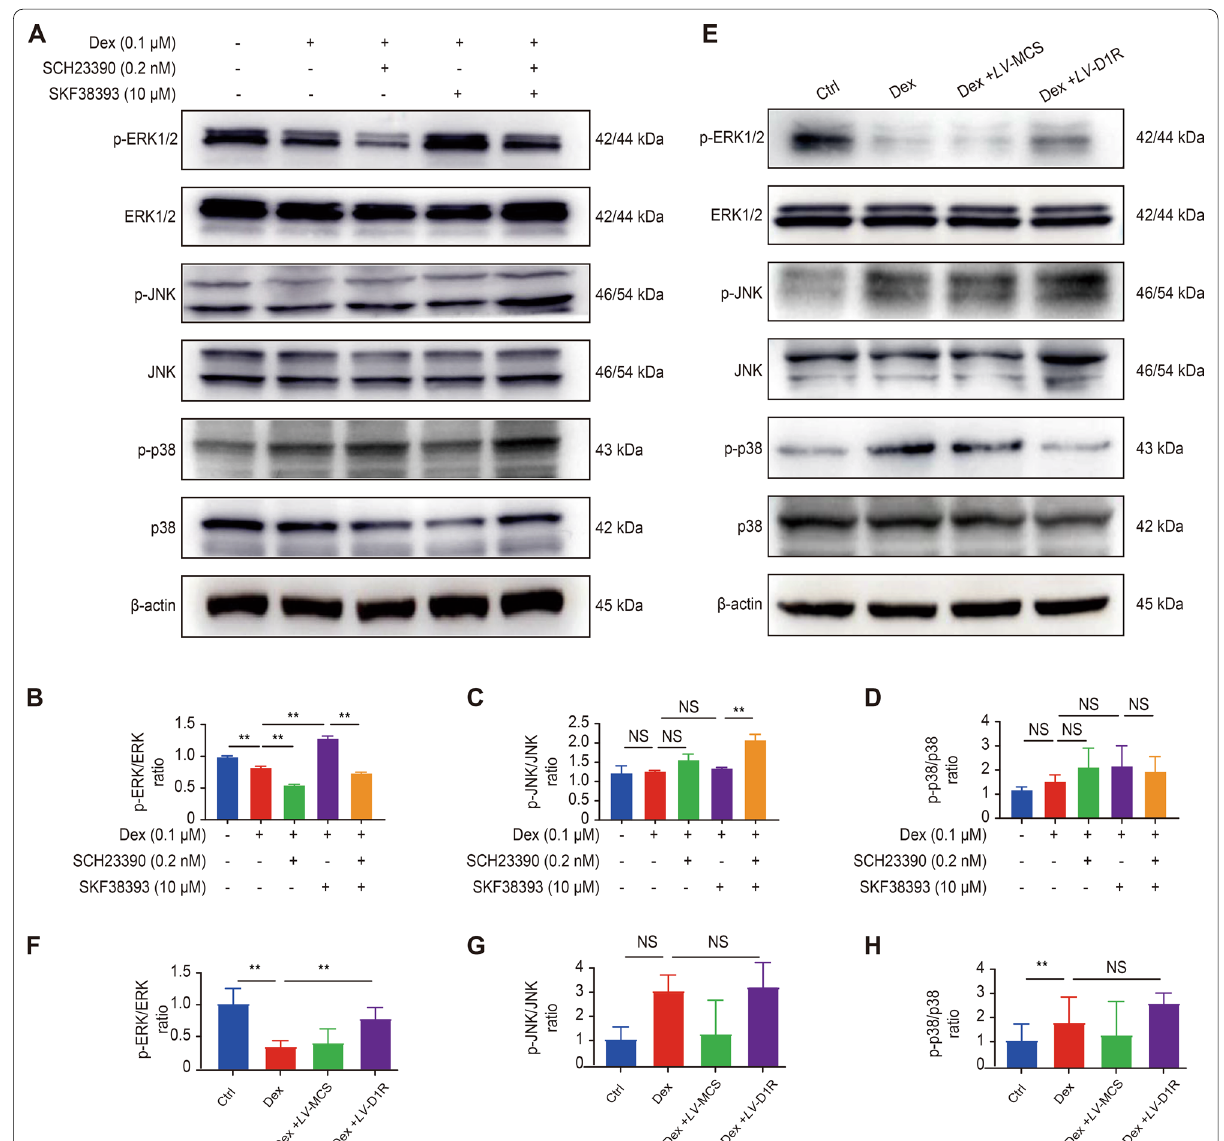
Fig. 4 The ERK1/2 pathway was involved in the protective effect of D1R against Dex-induced osteoblasts in vitro. A Representative images of western blots probed with antibodies against the MAPK signaling pathway proteins p-ERK1/2, ERK1/2, p-JNK, JNK, p-p38, and p38 after 30 min’ Dex treatment. B – D The ratios of p-ERK1/2/ERK1/2, p-JNK/JNK, and p-p38/p38. n 3 per group. NS: Not statistically significant, * p < 0.05, ** p < 0.01, = vs. the control group. E Representative images of western blots probed with antibodies against the MAPK signaling pathway proteins p-ERK1/2, ERK1/2, p-JNK, JNK, p-p38, and p38 in the overexpression experiment. F – H The ratios of p-ERK1/2/ERK1/2, p-JNK/JNK, and p-p38/p38. n 3 per = group. NS: Not statistically significant, * p < 0.05, ** p < 0.01, vs. the control